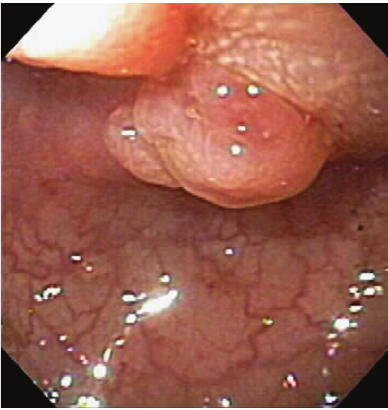
Figure 4: Endoscopy view showing lobular mass in the lumen of the sigmoid